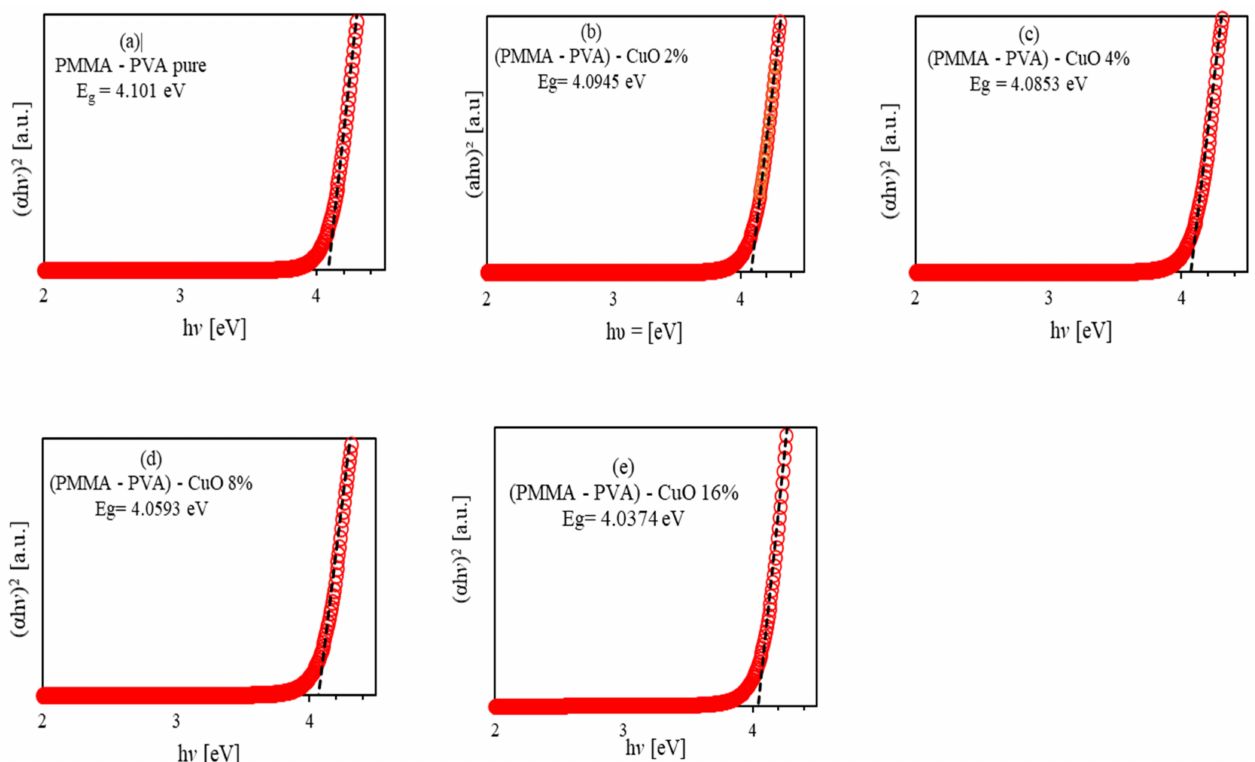
Figure 8. Tauc optical bandgap energy of PMMA–PVA/CuO nanocomposite thin films as a function of wavelength for various CuO NPs concentrations deposited by the dip-coating technique, ( a ) band gap of undoped PMMA–PVA polymer, ( b ) band gap of PMMA–PVA/CuO 2%, ( c ) band gap of PMMA–PVA/CuO 4%, ( d ) band gap of PMMA–PVA/CuO 8%, and ( e ) band gap of PMMA–PVA/CuO 16%.